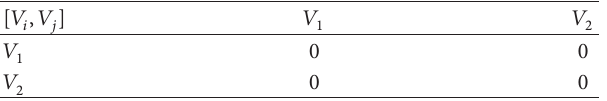
Table 5: Commutator table of the Lie algebra of (2.4).